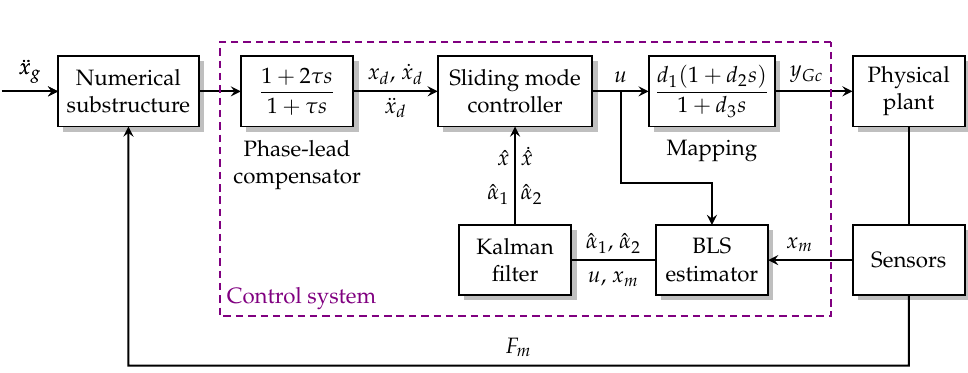
Figure 13. Block diagram of the control system in RTHS.